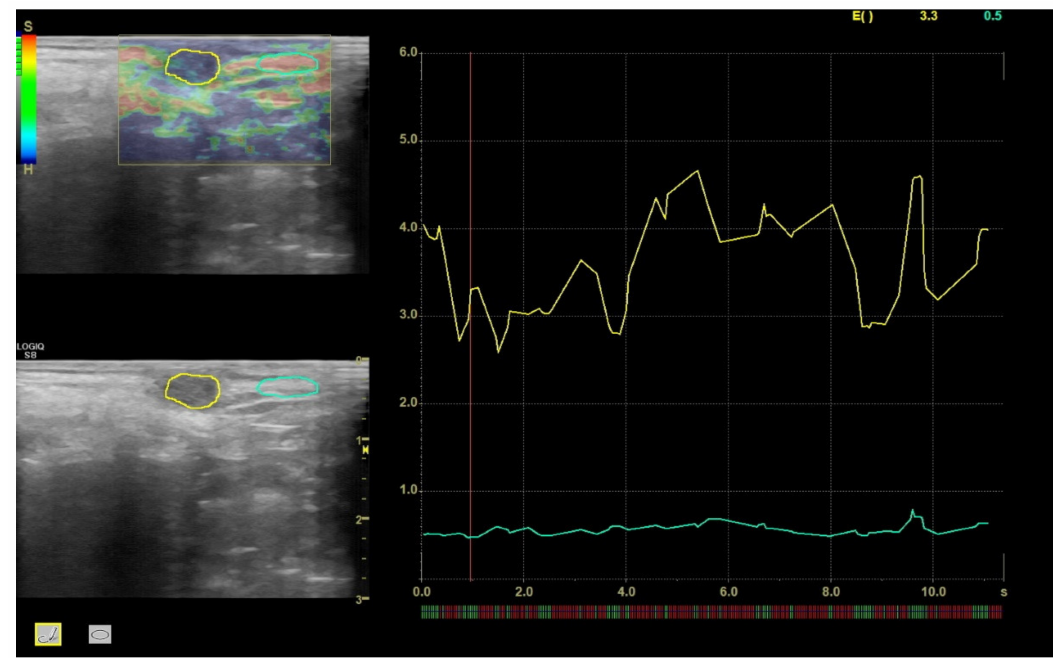
Figure 1. A representative image of the semi-quantitative measurements of STE-I and STE-R in a mammary nodular lesion in a bitch (sample No. 12d). The graduation scales reported in the left upper corner refer to the quality of the image acquisition (green bar on the left) and the different degrees of stiffness (red-to-blue bar on the right).